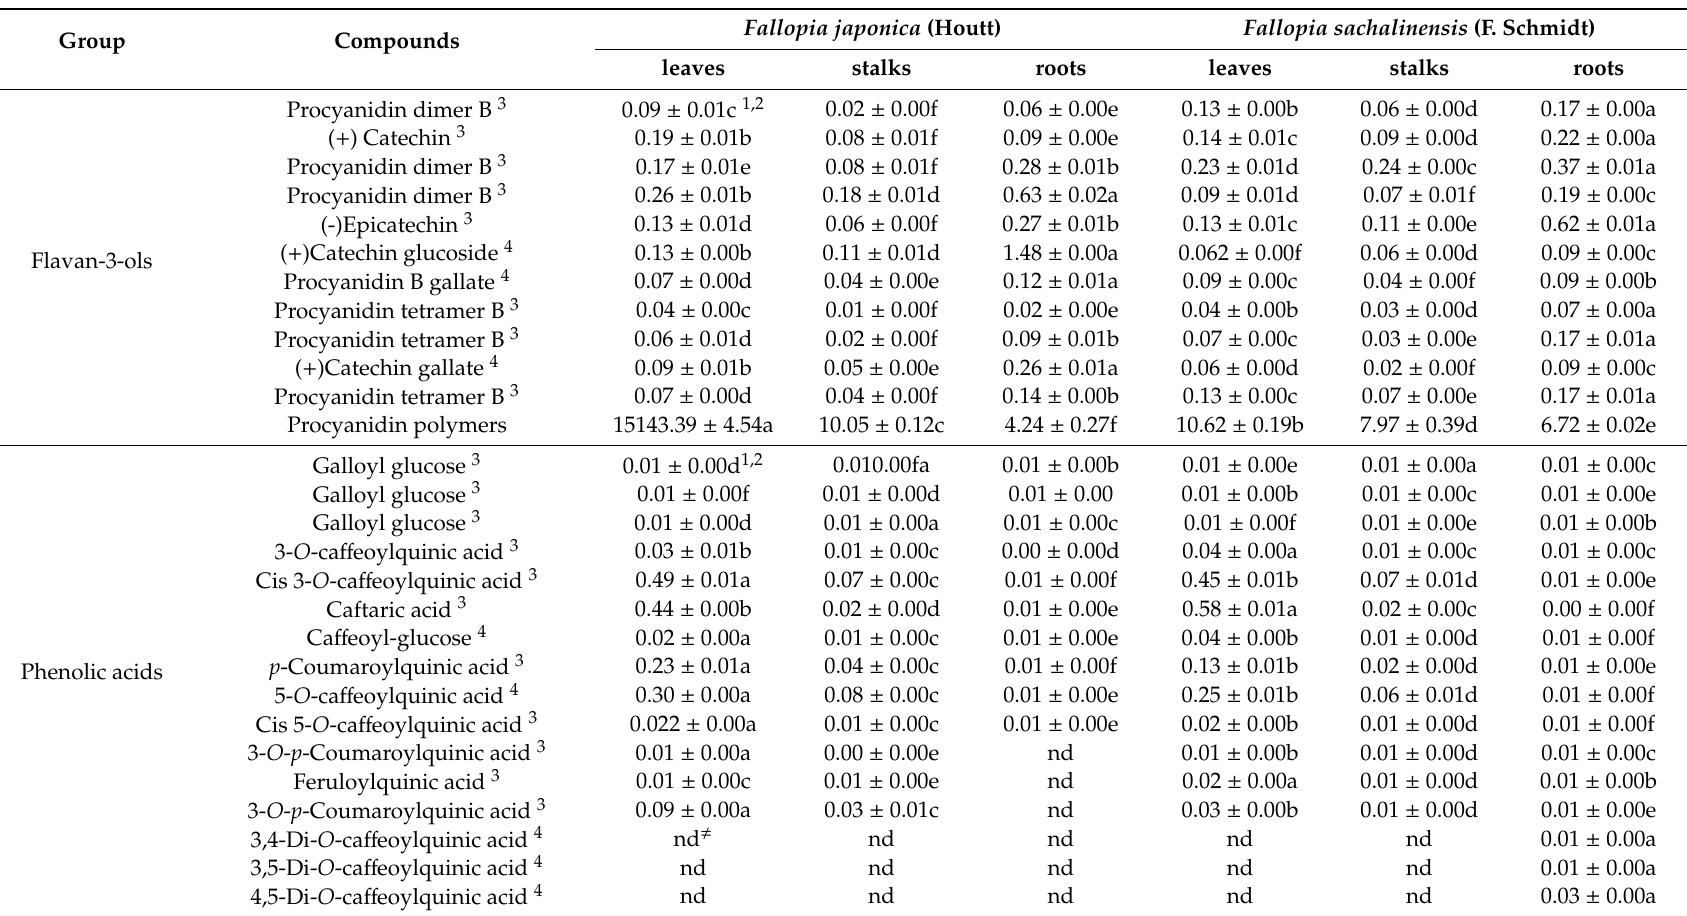
Table 2. Content of polyphenolic derivatives in wild Fallopia japonica (Houtt) and Fallopia sachalinensis (F. Schmidt) leaves, stalks, and roots. Fallopia japonica (Houtt) Fallopia sachalinensis (F. Schmidt) Group Compounds leaves stalks roots leaves stalks roots